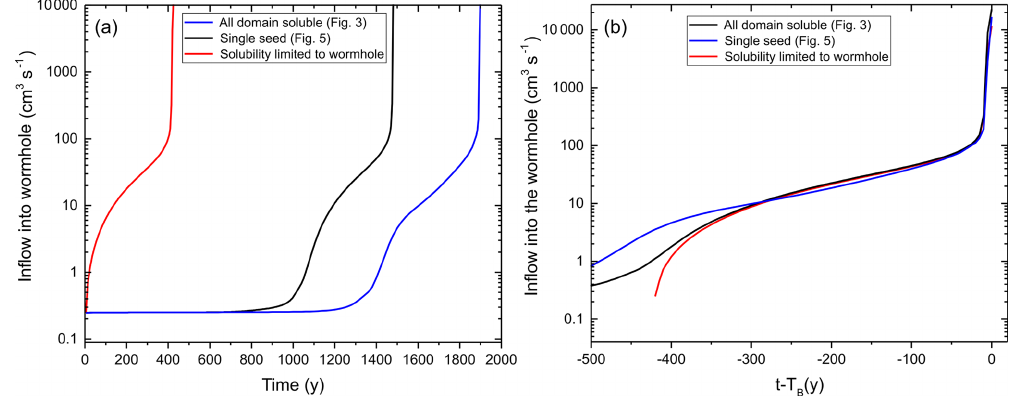
Figure 19. Inflow into the wormhole as a function of time (a) and as a function of time distance to the breakthrough time (b) for the uniform network (blue line, Fig. 3), for the single-seeded case (black line, Fig. 5), and for the case where only the fractures along the wormhole are soluble (red line).